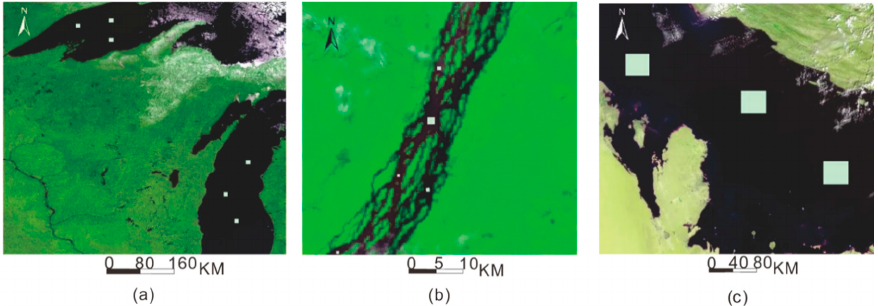
Figure 10. Three water spectral sampling image reference sample areas: ( a ) Lake Superior; ( b ) Congo river; ( c ) Persian Gulf.